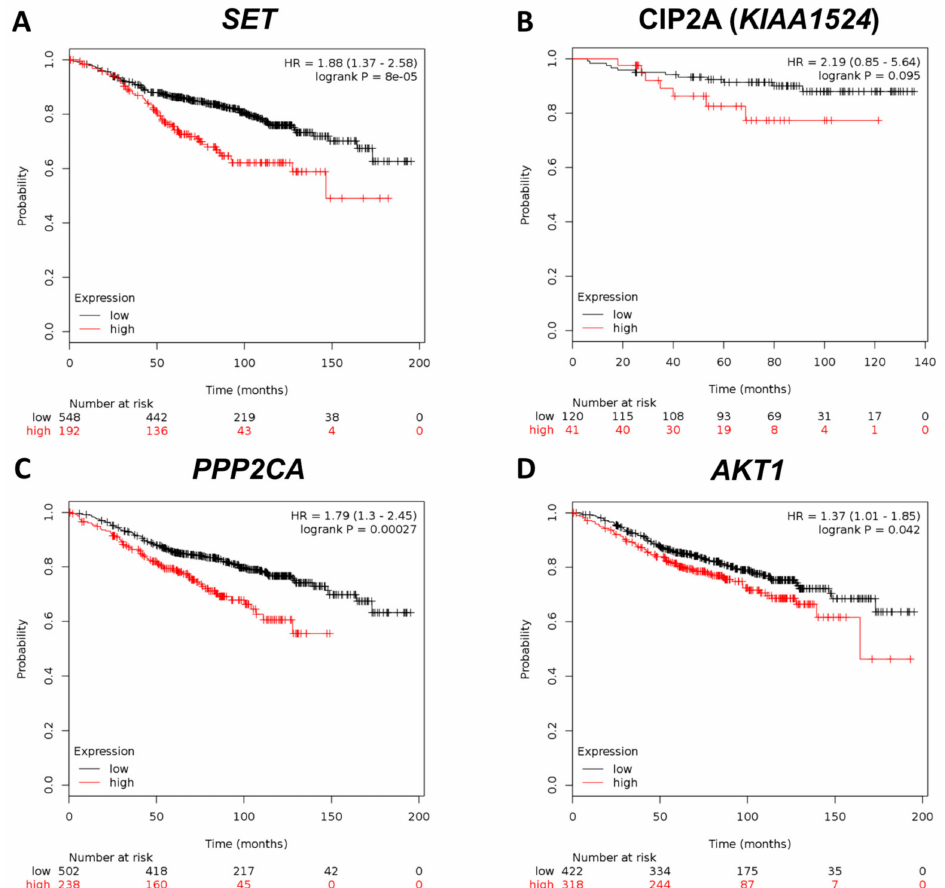
Figure 3. Clinical significance of gene biomarkers in human breast cancer patients. Kaplan–Meier analysis of the influence of SET ( A ), KIAA1524 ( B ), PPP2CA ( C ), and AKT1 ( D ) expression on RFS in patients with ER-positive breast cancer receiving adjuvant tamoxifen from the public platform